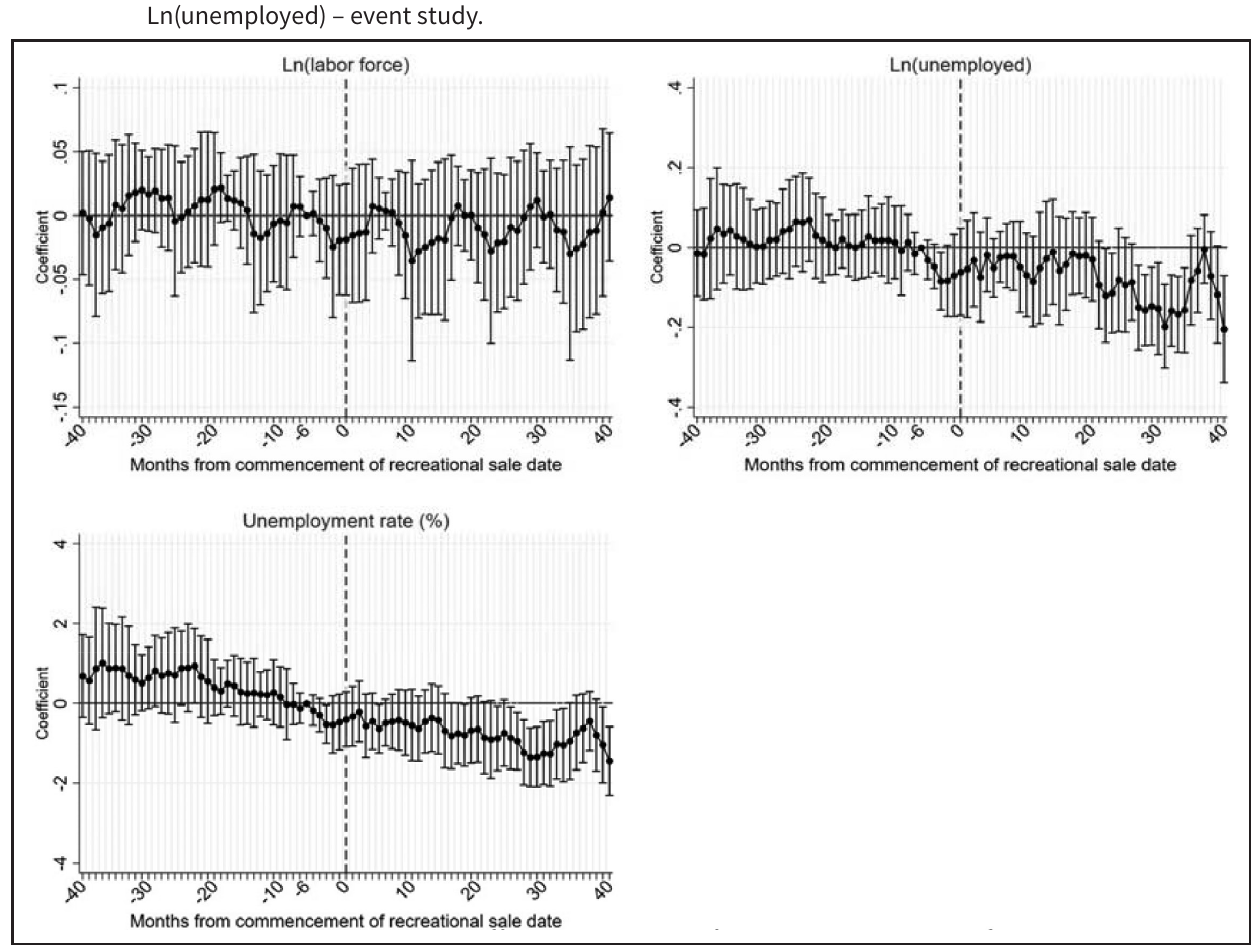
Figure A9 Effect of recreational cannabis entry on the unemployment rate, Ln(labor force), and Ln(unemployed) – event